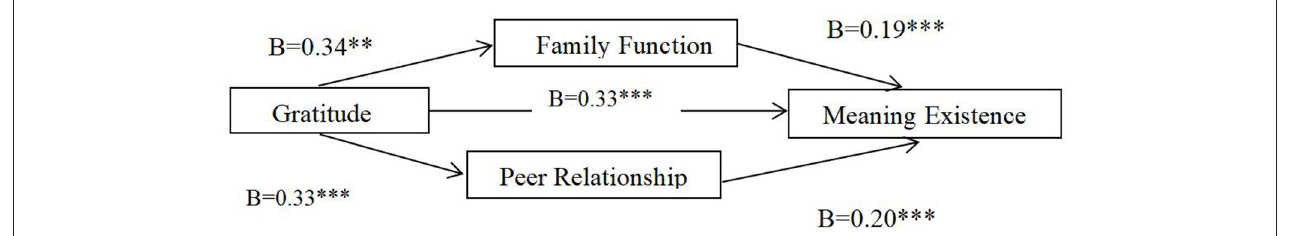
FIGURE 2 | The mediating effect model of family function and peer relationship between gratitude and meaningful existence. ** p < 0.01, *** p < 0.000.